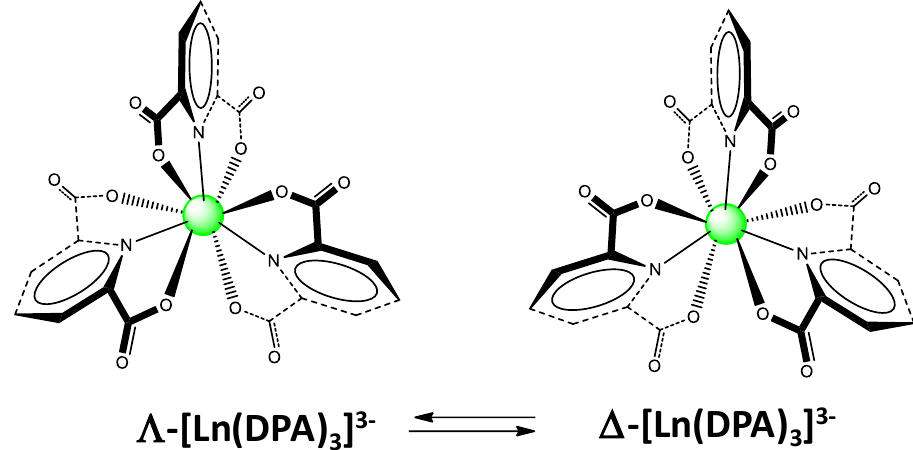
Figure 1. Structures of the Λ -[Ln(DPA) 3 ] 3 − ( left ) and ∆ -[Ln(DPA) 3 ] 3 − ( right ) complexes showing the helical wrapping of achiral 2,6-pyridinedicarboxylate (DPA) ligands for 1:3 Ln 3+